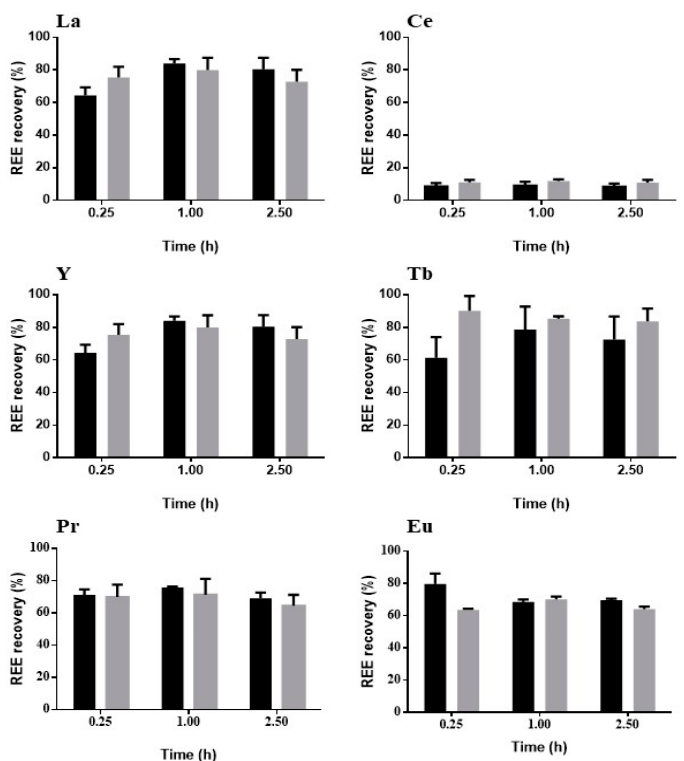
Molecules 2019 , 24 , x 15 of 26